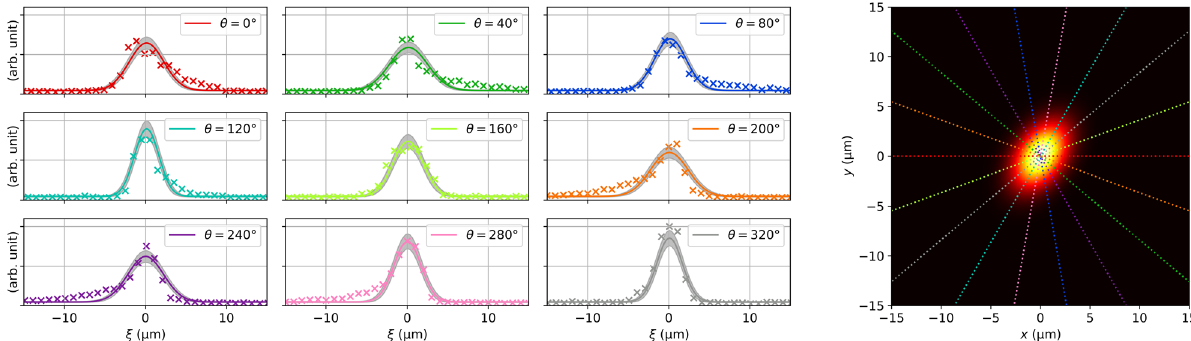
FIG. 9. The result of a single Two-dimensional Gaussian fit to approximate nine measured projections. The measurement and the beam profile are shown analogously to the tomographic result shown in Fig. 8. In contrast to the tomographic reconstruction, the Gaussian fit is not able to represent the tails